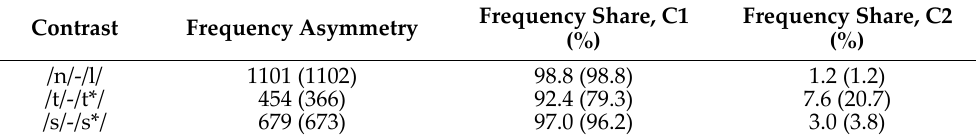
Table 2. Data from the NIKL corpus on spoken frequency asymmetries between words with the same first syllable as stimulus items in Ahn et al. (2017). Data including words with a similar first syllable containing a coda /k/ are included in parentheses. The frequency share of the first (C1) and second (C2) member of the contrast indicates the percentage of the total frequency of the contrast represented by that member.